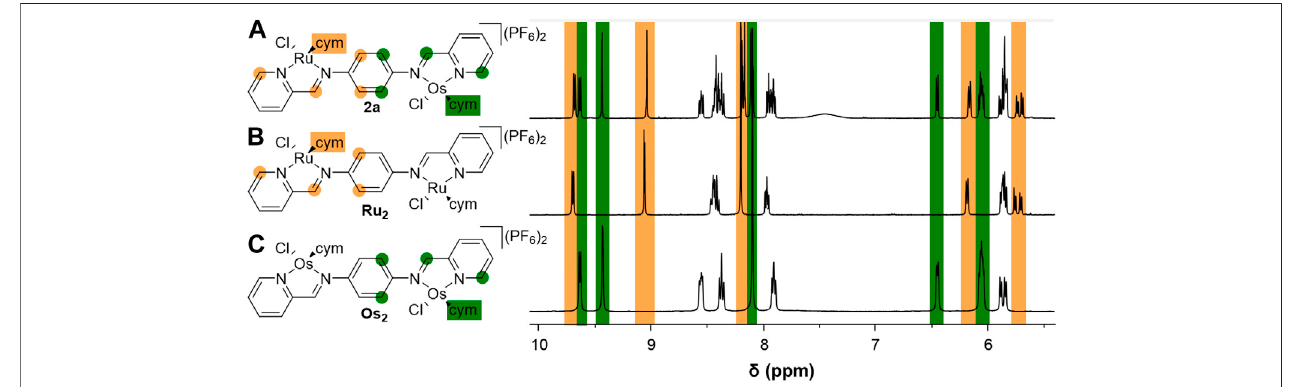
FIGURE 2 | Comparison of the 1 H NMR spectra for the heterodimetallic Ru-Os complex 2a (A) , to those of the symmetric Ru 2 (B) and Os 2 (C) derivatives.